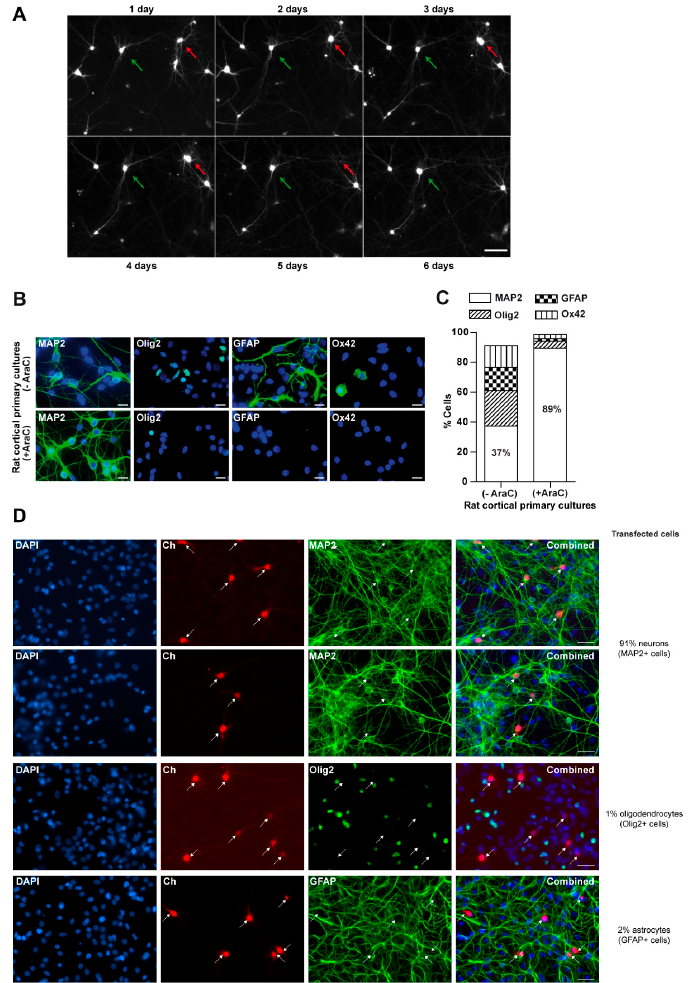
Figure 1. Longitudinal survival analysis in mixed and neuron-enriched cortical primary cultures. ( A ) Example of longitudinal tracking with automated microscopy of individual rat cortical primary neurons transiently transfected with green fluorescent protein (GFP). The green arrow points to a GFP-expressing neuron tracked longitudinally for up to 6 days post-transfection. The red arrow points to another GFP-expressing neuron that survives 4 days post-transfection. Magnification bar: 50 µ m. ( B )Characterizationofmixed( − AraC)andneuron-enriched( + AraC)primarycultures. Ratcorticalprimary cultures were treated with 10 µ M AraC at DIV2 for 48 h to prevent glial proliferation. Photomicrographs with representative images corresponding to mixed (upper row) and neuron-enriched (lower row) cultures. The cellular composition of both types of cultures was characterized by immunofluorescence using the following markers: MAP2 for neurons, Olig2 for oligodendrocytes, GFAP for astrocytes and Ox42 for microglia. Cellular nuclei were stained with DAPI. Magnification bars: 10 µ m. ( C ) Quantification of the percentage of each cell type relative to the total number of cells (DAPI positive nuclei). Each percentage corresponds to the mean of 3 independent experiments +/ - the standard error of the mean: in mixed cultures: MAP2 89 +/ − 3.2, GFAP 15 +/ − 1.4, Olig2 24 +/ − 1.5 and Ox42 15 +/ − 1.5; in neuron-enriched cultures: MAP2 89 +/ − 3.2, GFAP 1.5 +/ − 0.1, Olig2 5 +/ − 0.7 and Ox422.8 +/ − 1.2 ( D ) Estimation of the percentage of transfected cells that are neurons. Mixed rat primary neuronal cultures were transfected with a plasmid expressing mCherry (Ch). Neurons were fixed 24 h after transfection and immunostained with specific antibodies against MAP2, Olig2 and GFAP. Around 90 transfected cells per condition were analyzed. Magnification bars: 25 µ